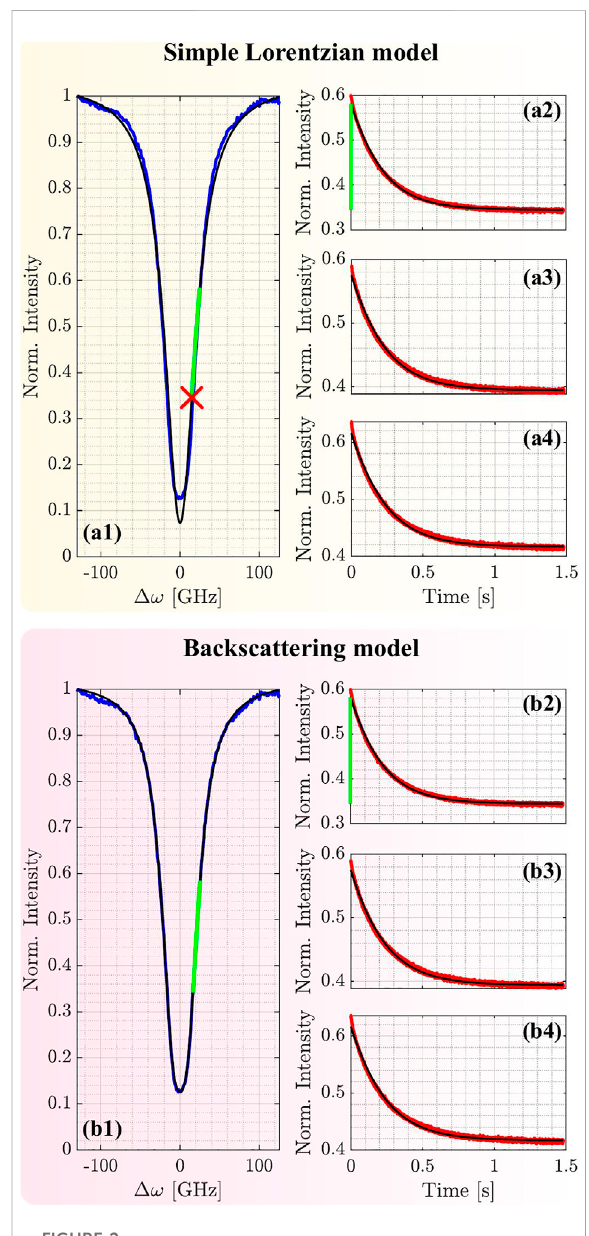
FIGURE 2 Microresonator in thepackagedchip. (a1) transmission of the through port as a function of the detuning Δ ω . The blue line is the experimentaldata,theredcrossisthespectralpositionoftheinput signal for the time decay experiments of (a2 – a4) , the green linerefersto thespectralshift observed during themicroresonator cooling, the black line is a fi t with a simple Lorentzian model. (a2 – a4) transmission intensity as a function of time after the switch-off of the current driving the microheater placed at a distance of 1275 μ m, 655 μ m and 240 μ m, respectively. Red lines refer to the experimental data, black lines to the fi t curve. (b1 – b4) showthesameexperimentaldataas (a2 – a4) but fi twithadifferent model which takes into account backscattering